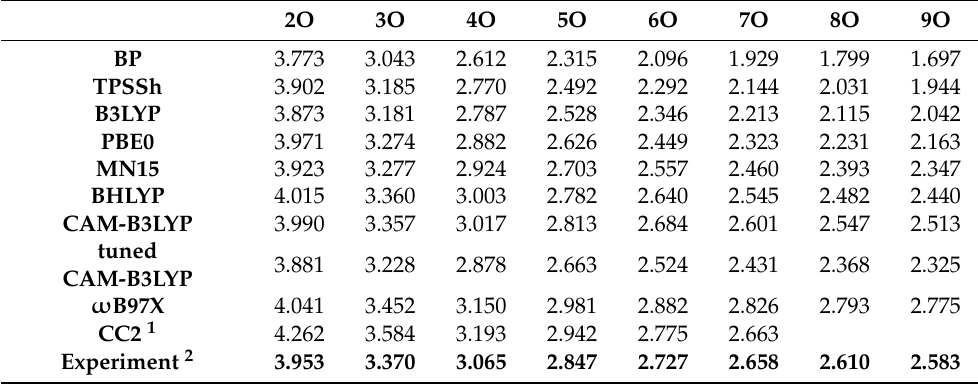
Table 2. Vertical emission energies calculated for the studied oligofurans using the selected variants of DFT/TDDFT and the CC2 method with the def2-TZVPP basis